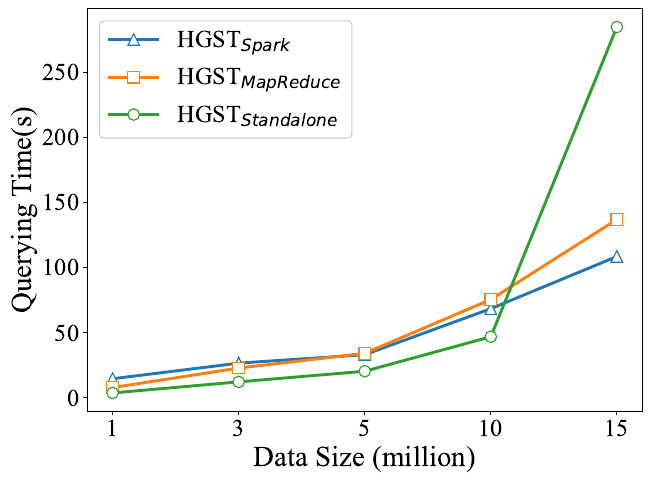
Figure 16. The effect of using Spark to complete the spatio-temporal range query (for HGST Standalone , the time window is reduced to 70% of the original when data size is 15